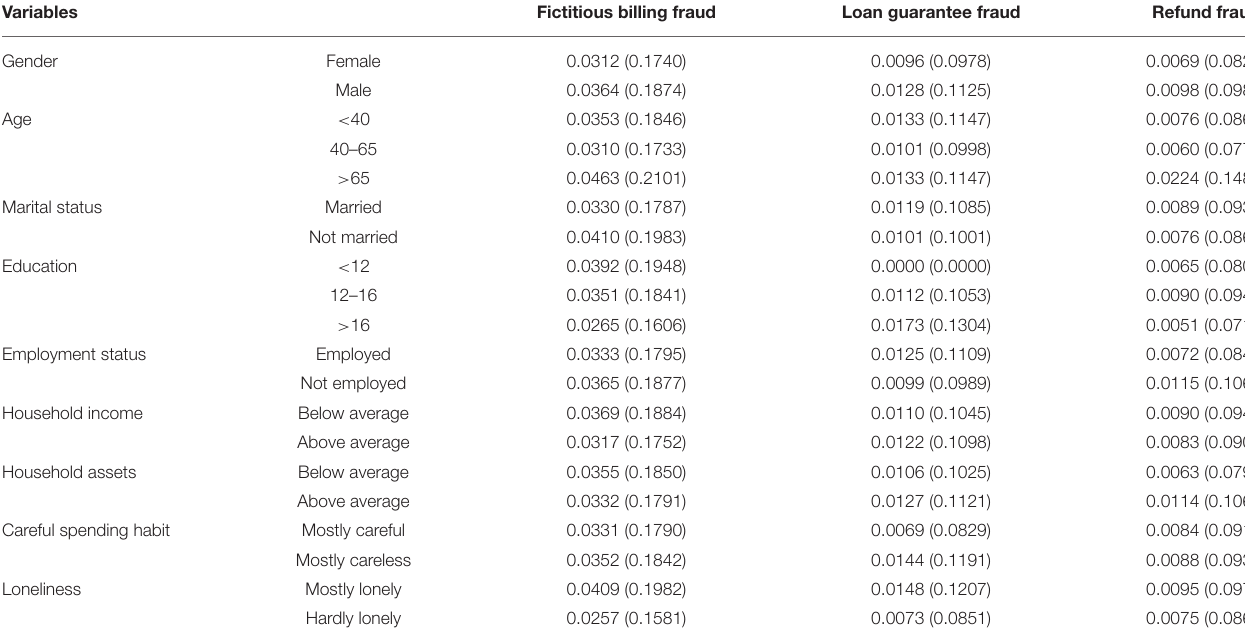
TABLE 3 | Detailed description of special financial frauds based on important